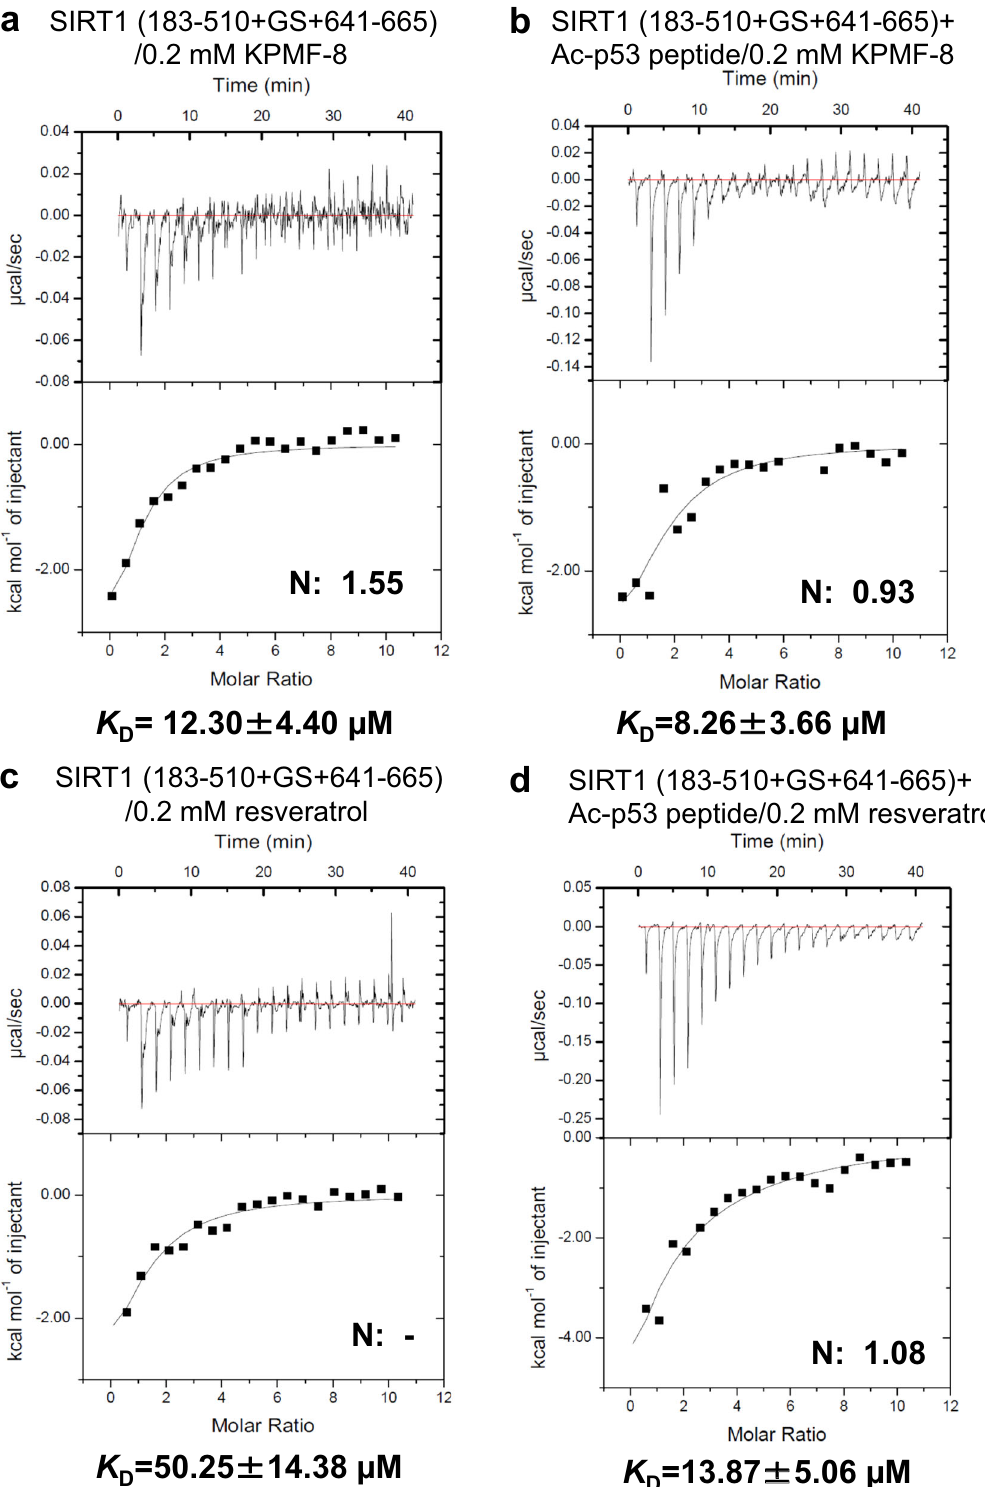
Fig. 3 Binding of KPMF-8 or resveratrol to SIRT1 (183 – 510 + GS + 641 – 665) determined using ITC. Binding of KPMF-8 to SIRT1 (183 – 510 + GS + 641 – 665) a without Ac-p53 peptide and b with 0.2 mM Ac-p53 peptide. Binding of resveratrol to SIRT1 (183 – 510 + GS + 641 – 665) c without Ac-p53 peptide and d with 0.2 mM Ac-p53 peptide. K D values ± curve- fi t errors are indicated underneath each